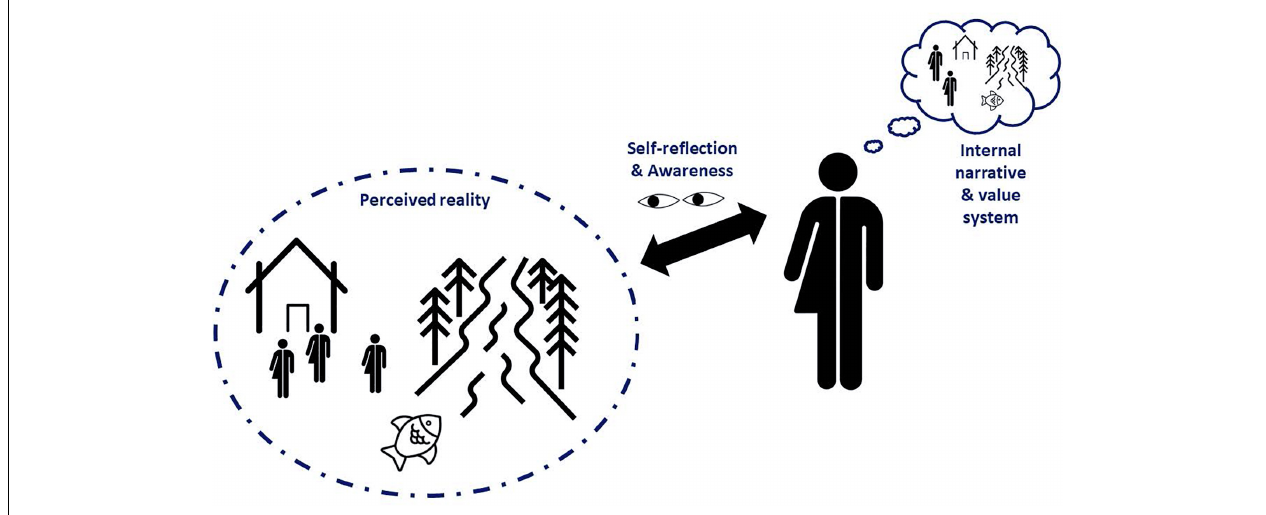
FIGURE 3 | Becoming aware of the influence of one’s internal narrative and value system on our perception of reality through engaging in critical